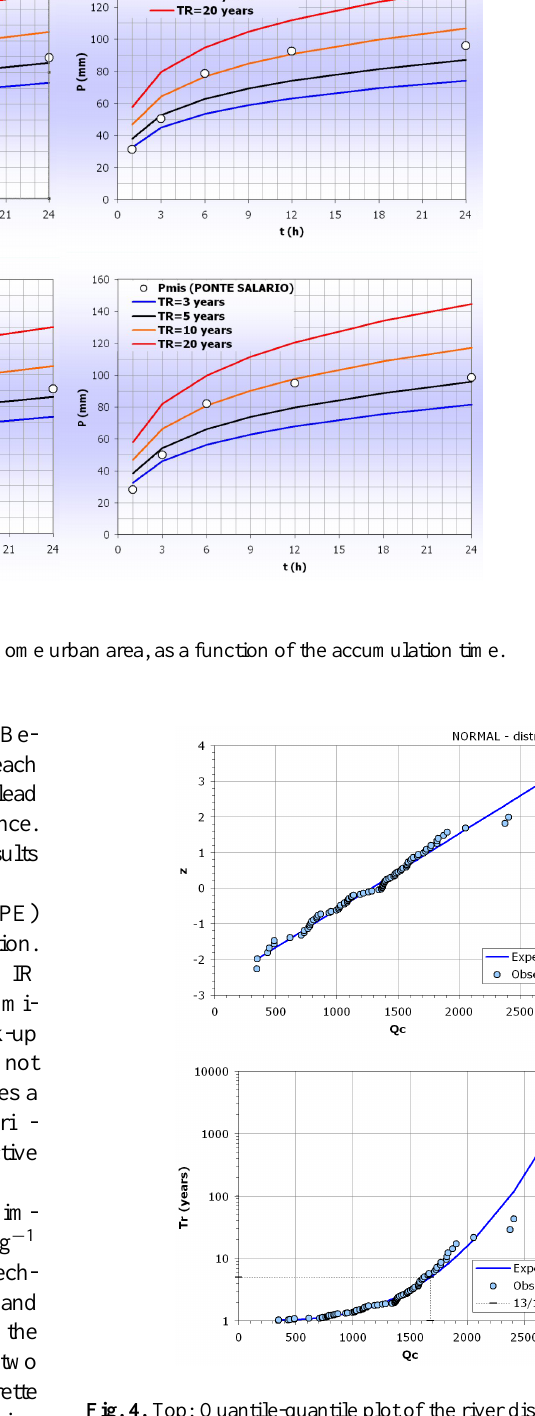
Fig. 4. Top: Quantile-quantile plot of the river discharge frequency distribution at Ripetta station. Bottom: return period associated to the observed peak discharge value (normal distribution), with indi- cation of the observed peak discharge value.